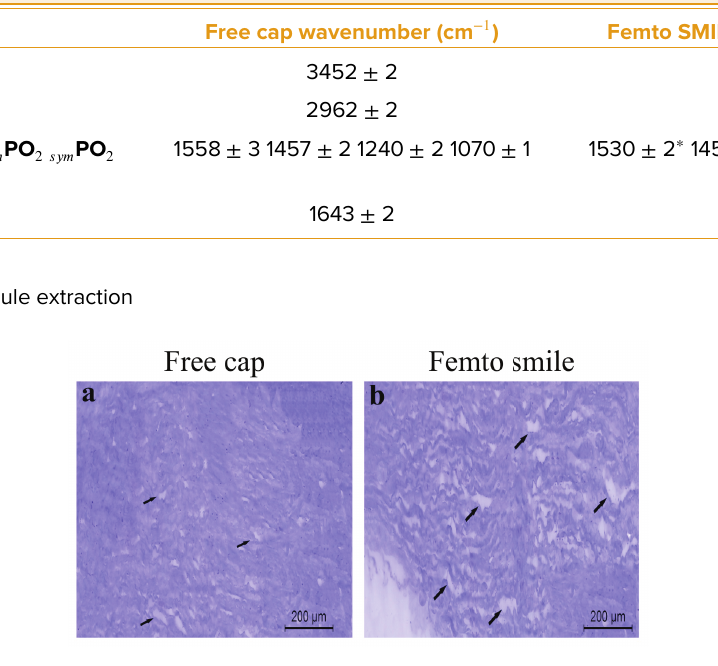
Figure 1. Light microscope picture for (a) free cap showing slight stromal edema and (b) Femto SMILE showing homogeneous and more edematous stroma (arrows).